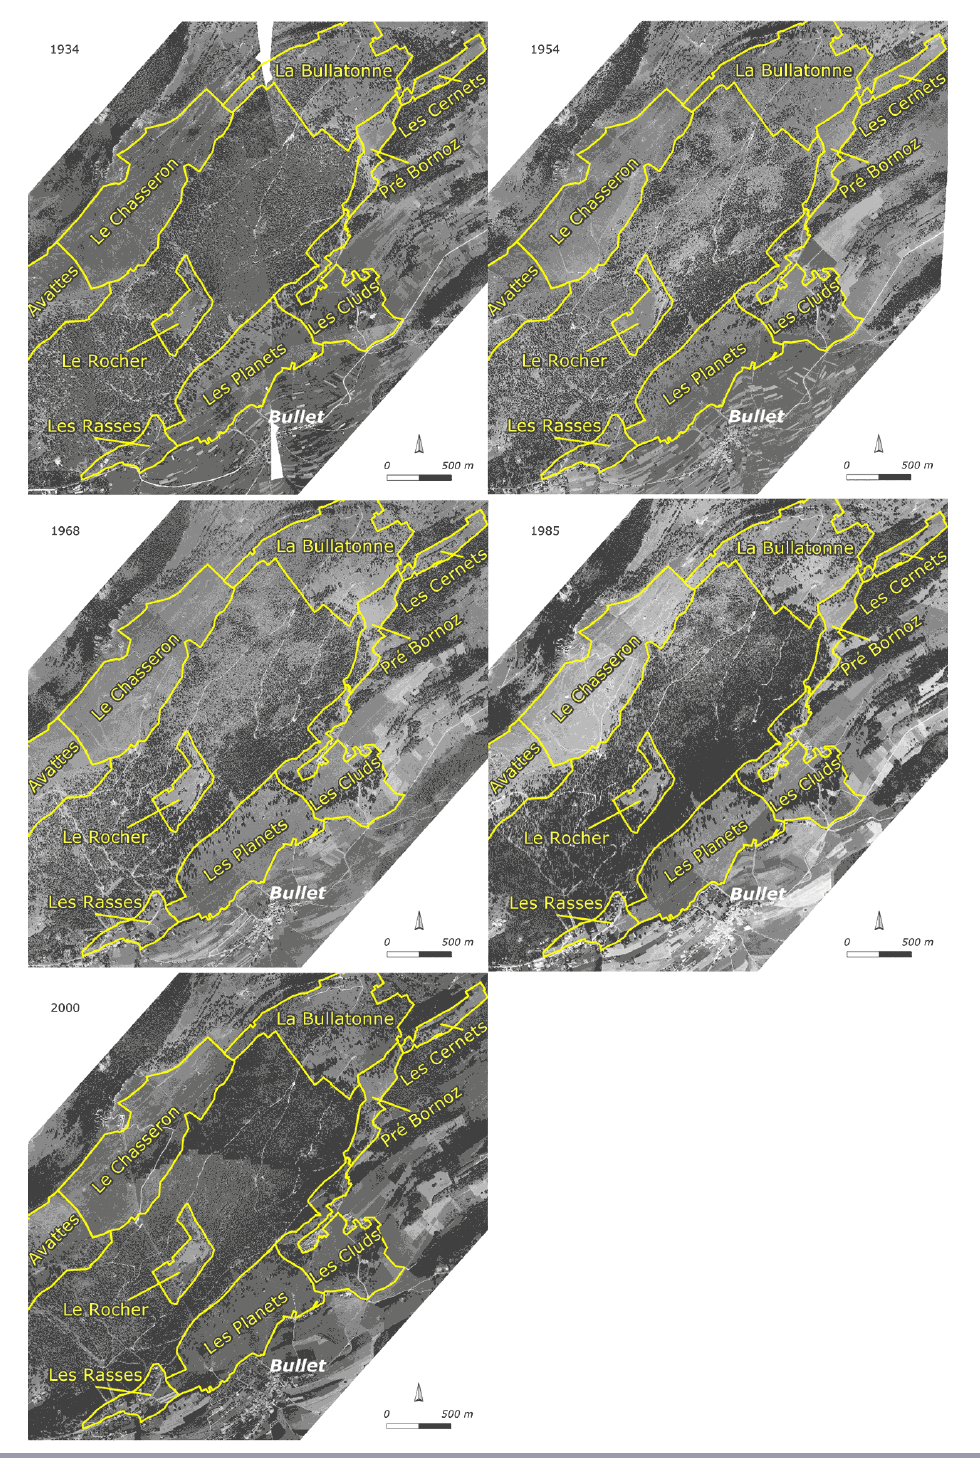
Fig. 3 . Aerial images of the pastures in Bullet showing their spatial organization, including the farms of Les Rasses, Les Planets, and Les Cluds (source: